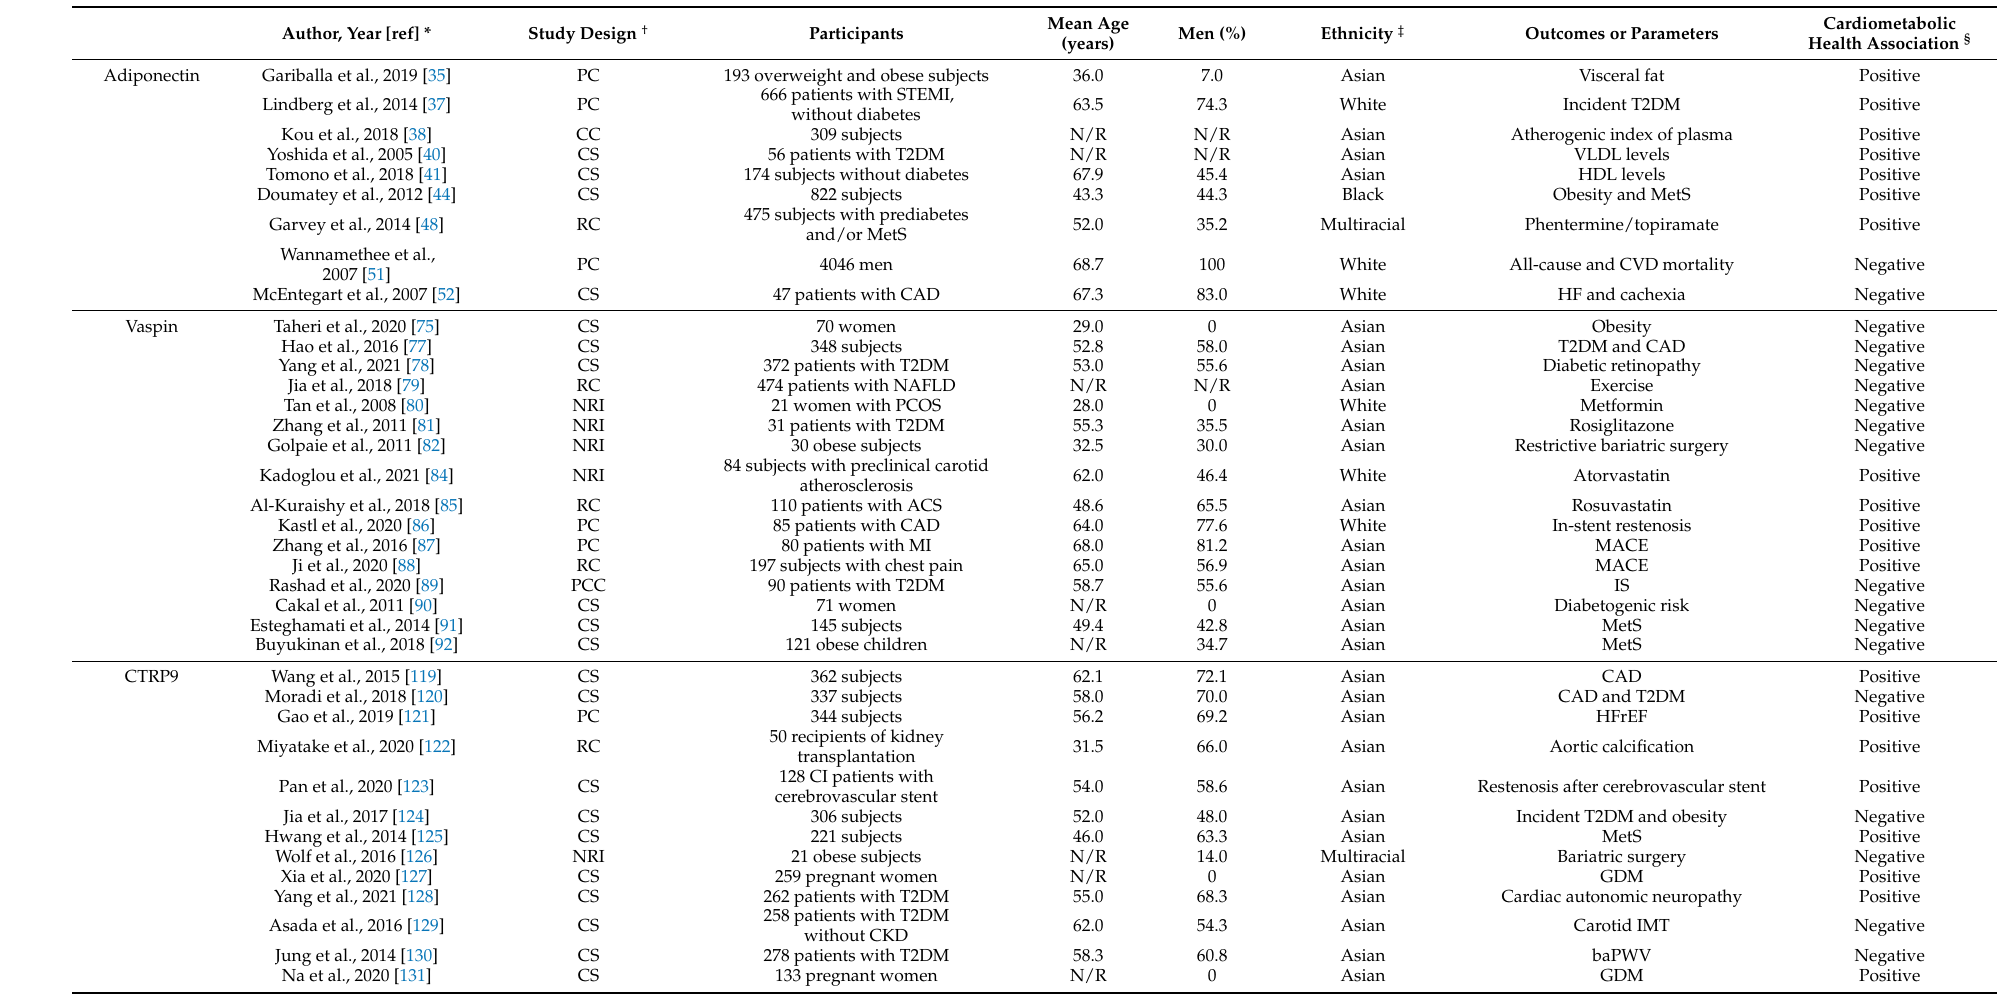
Table 1. Summary of the human studies for the association of adipokine levels with cardiometabolic